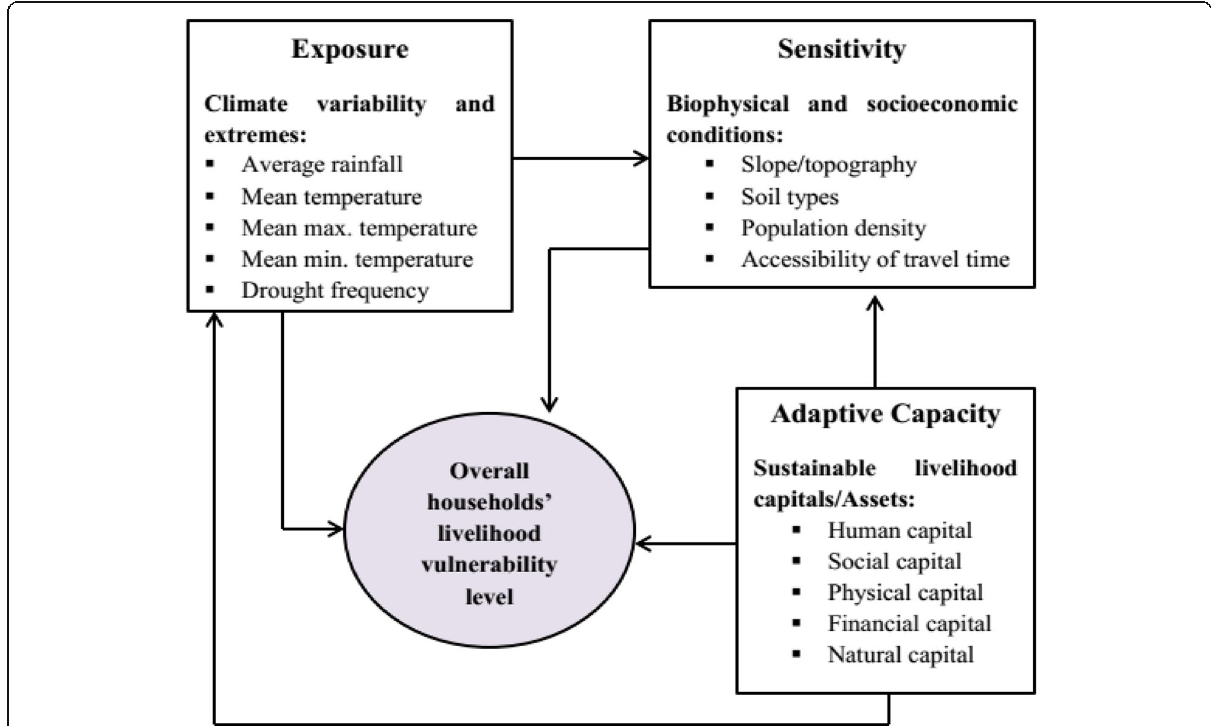
Fig. 1 A schematic diagram showing a set of predictor variables of exposure, sensitivity, and adaptive capacity to the overall households ’ livelihood vulnerability